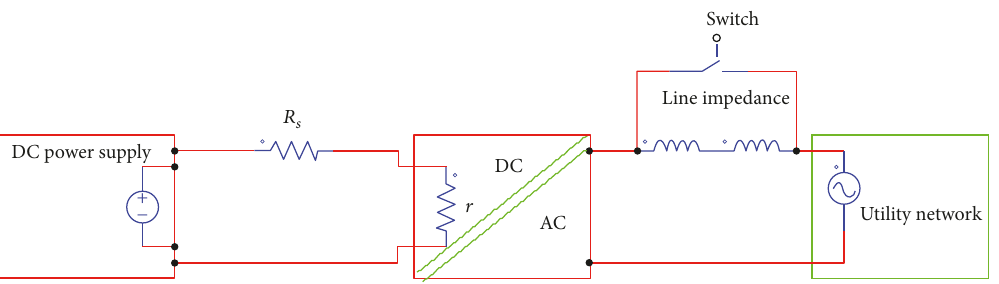
Figure 7: Testing the impact of the weak grid connection on the SB 1700E inverter by adding an additional inductor.